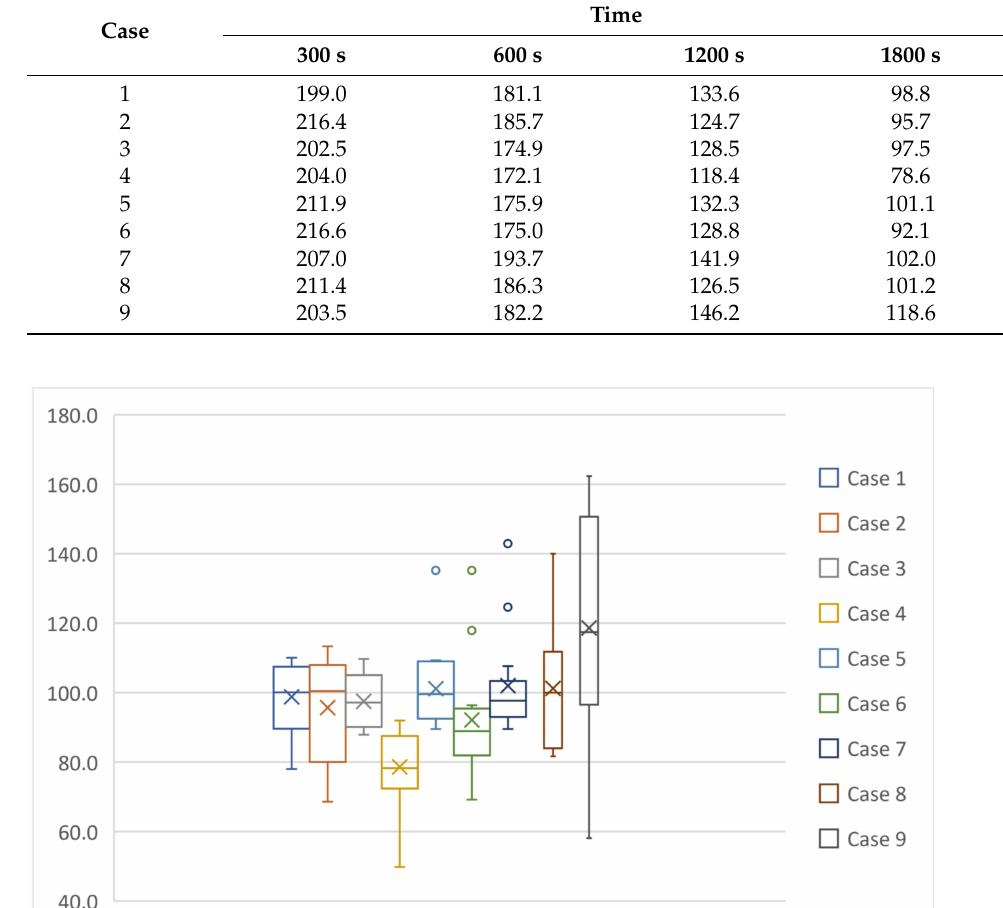
Table 4. The average concentration of all observation points for the nine cases (unit is µ g/m 3 ).